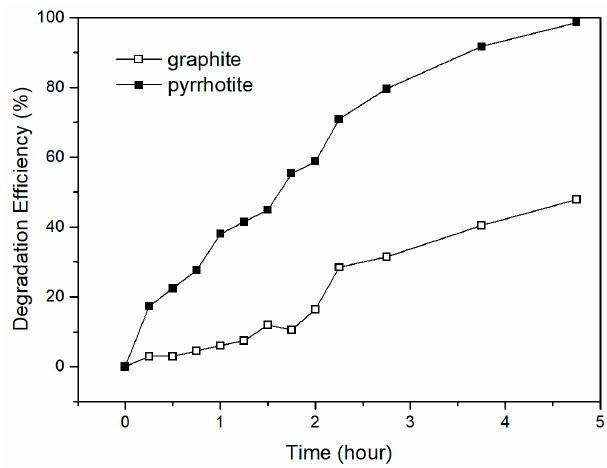
Figure 3. Degradation efficiencies of Cr (VI) in MFCs equipped with pyrrhotite-coated and normal graphite cathodes.